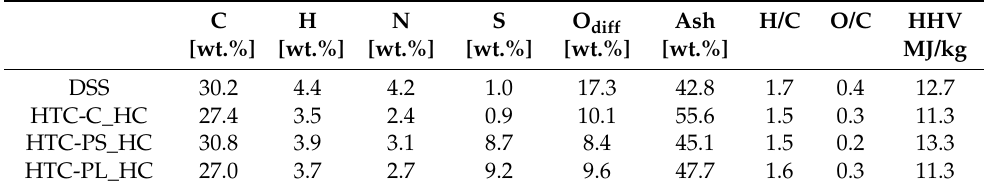
Table 1. Ultimate analysis and higher heating values (HHV) of digested sewage sludge (DSS) and its derived hydrochars (HTC-xx). (C = Control; PS = P stripping; PL = P leaching; HC = Hydrochar) ( n =